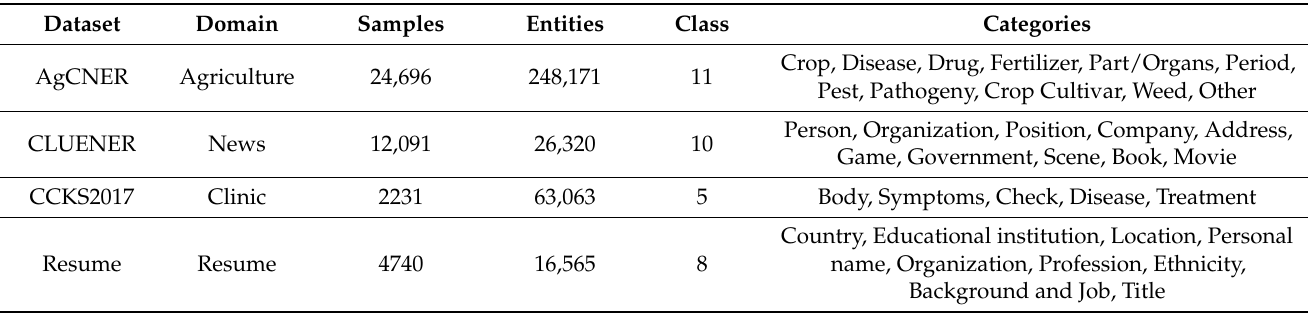
Figure 2. The proportion of each category in the data sets. ( a ) Illustrates the data distribution of each category in AgCNER; ( b ) shows the data distribution of each category in CLUENER. Table 1. The detailed information of all datasets.